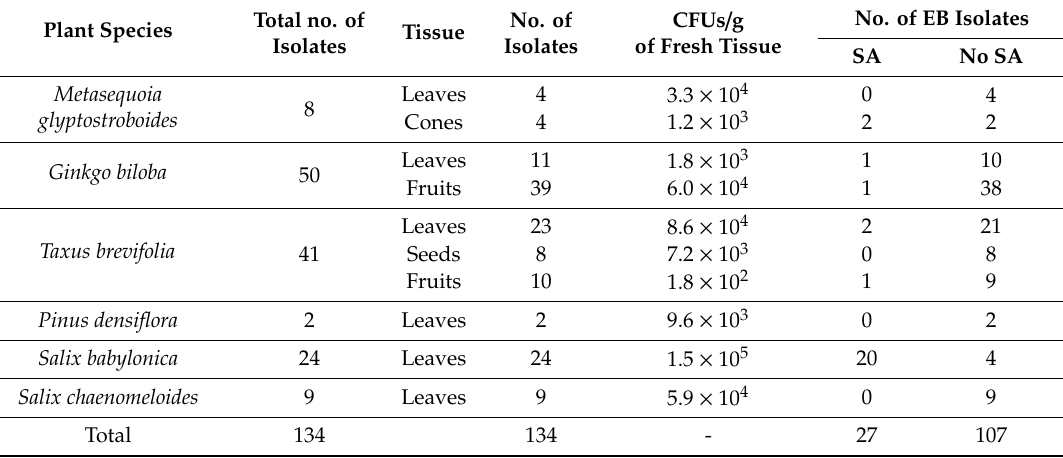
Table 1. Isolation of salicylic acid-producing endophytic bacteria from six plant species. No. of CFUs / g Plant Species Total no. of Tissue Isolates Isolates of Fresh